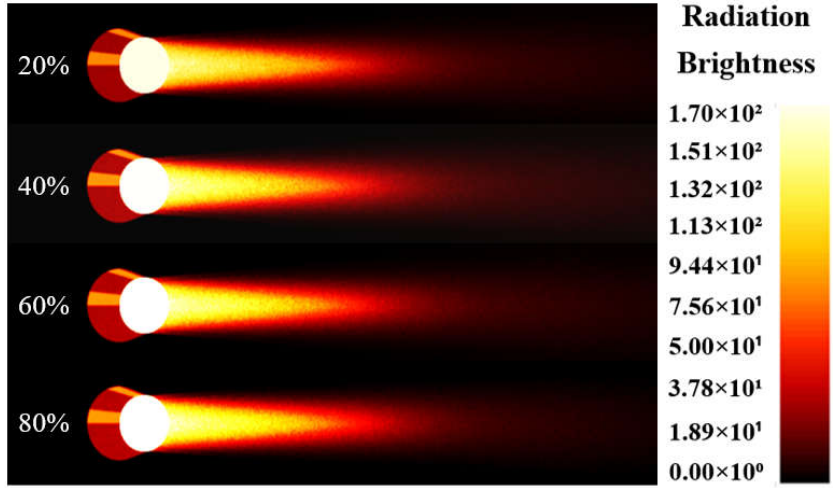
Figure 17. Imaging comparison of different damage degrees at 30 ◦ .